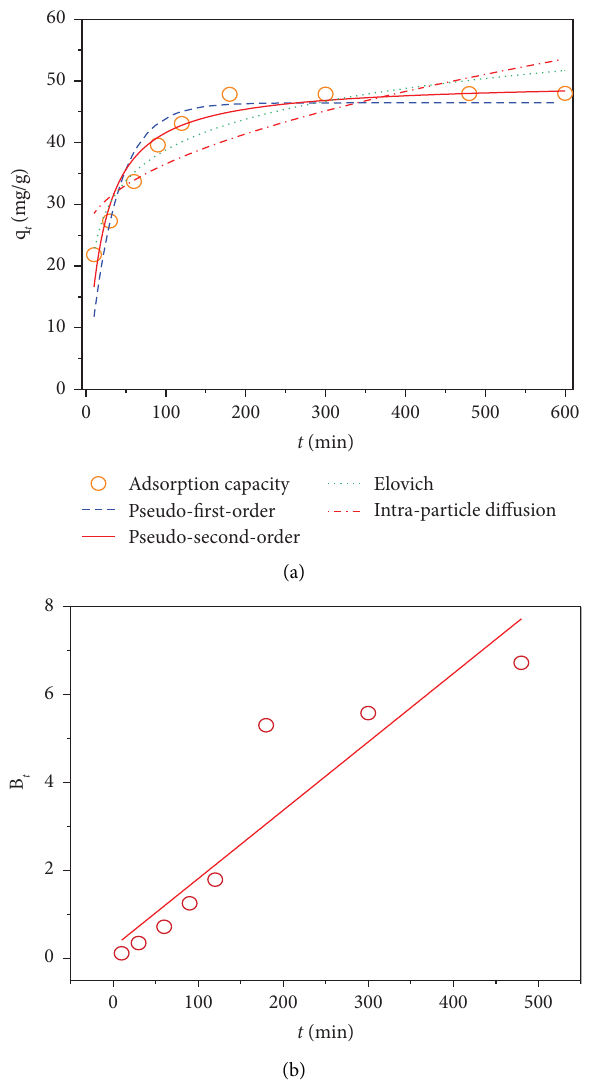
Figure 4: Adsorption kinetics model, (a) and Boyd kinetic model, (b) of Cl- removal by